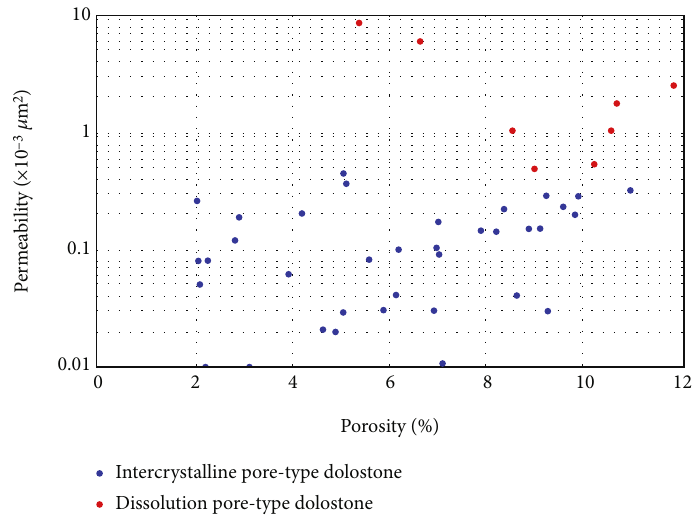
Figure 4: Cross-plot of porosity versus permeability of submember Ma5